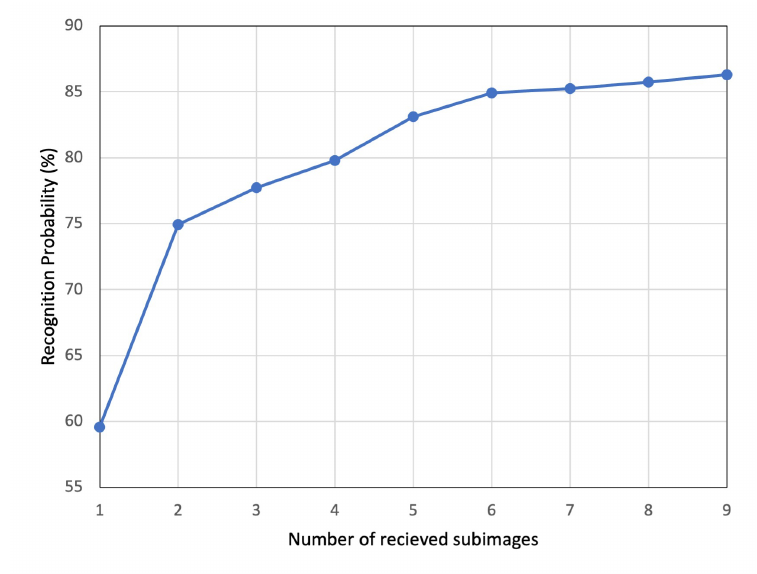
Figure 8. Average probability trend with increase in number of subimages received.